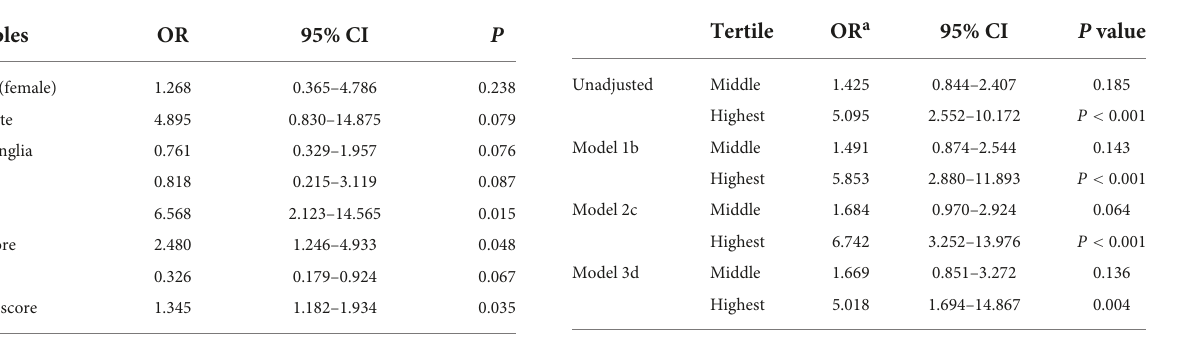
TABLE 5 Multivariate logistic regression analysis model of MHR and